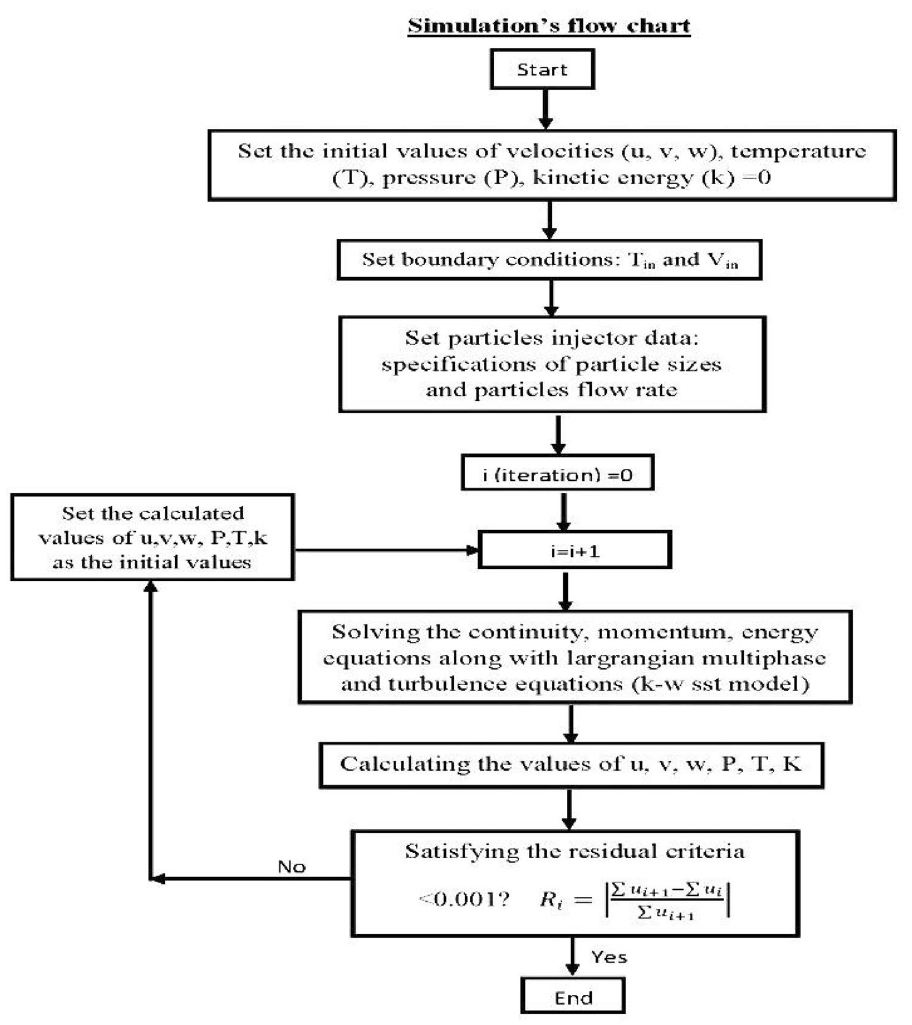
Figure 9. Flow chart of numerical